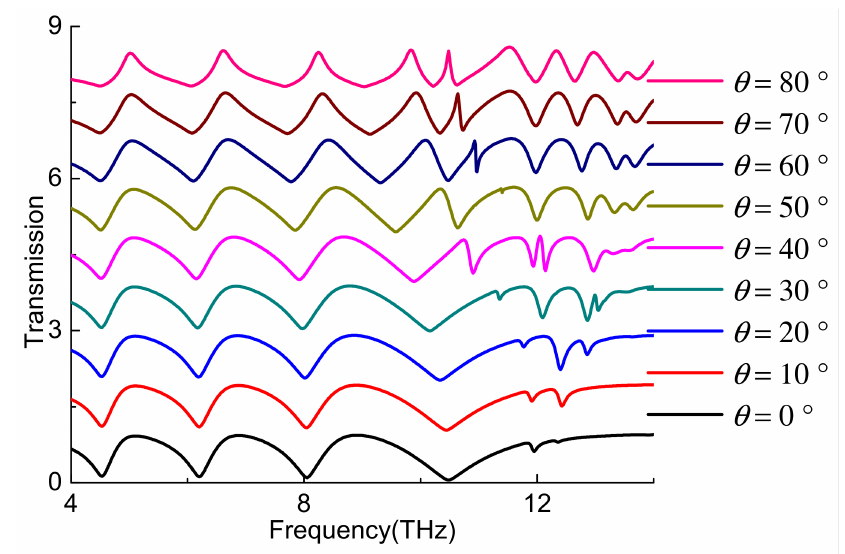
Figure 10. The transmission spectra under oblique incident angle θ .